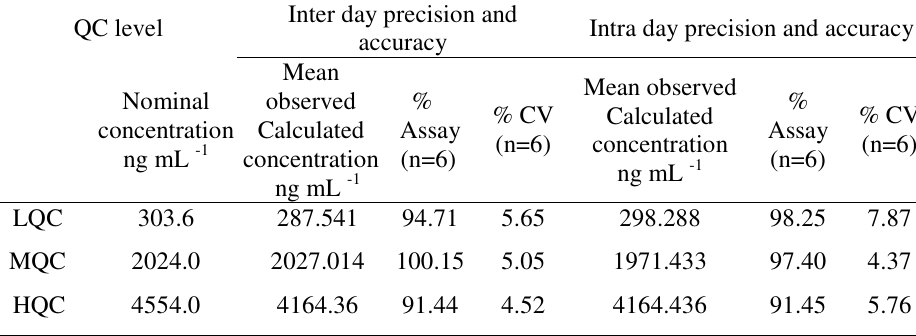
Table 3 . Data of Inter Day Precision and Accuracy